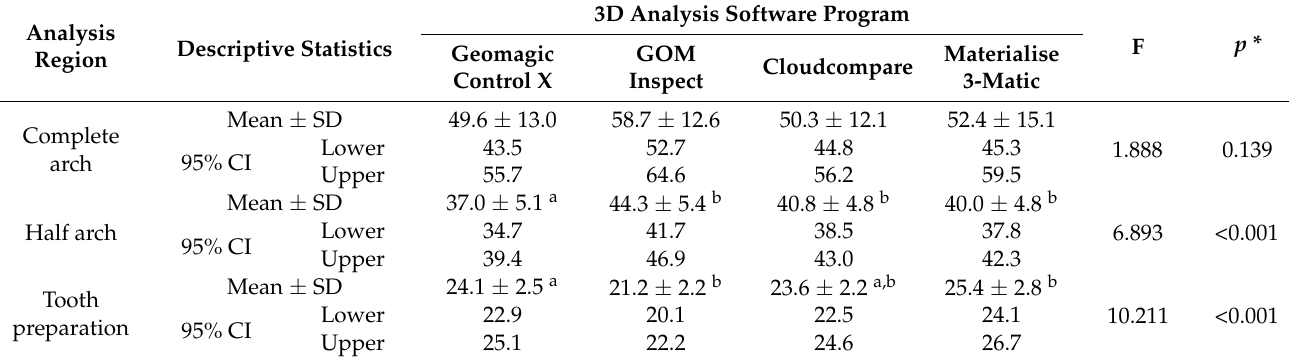
Table 2. Comparison of RMS ( µ m) of complete-arch, half-arch, and tooth preparation region evaluated by using four analysis software programs.